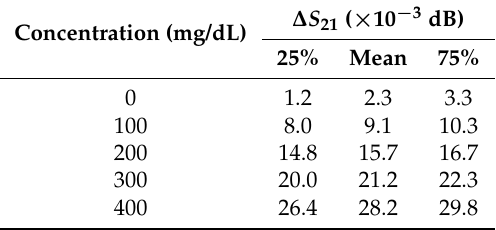
Table 2. Summary of the statistical